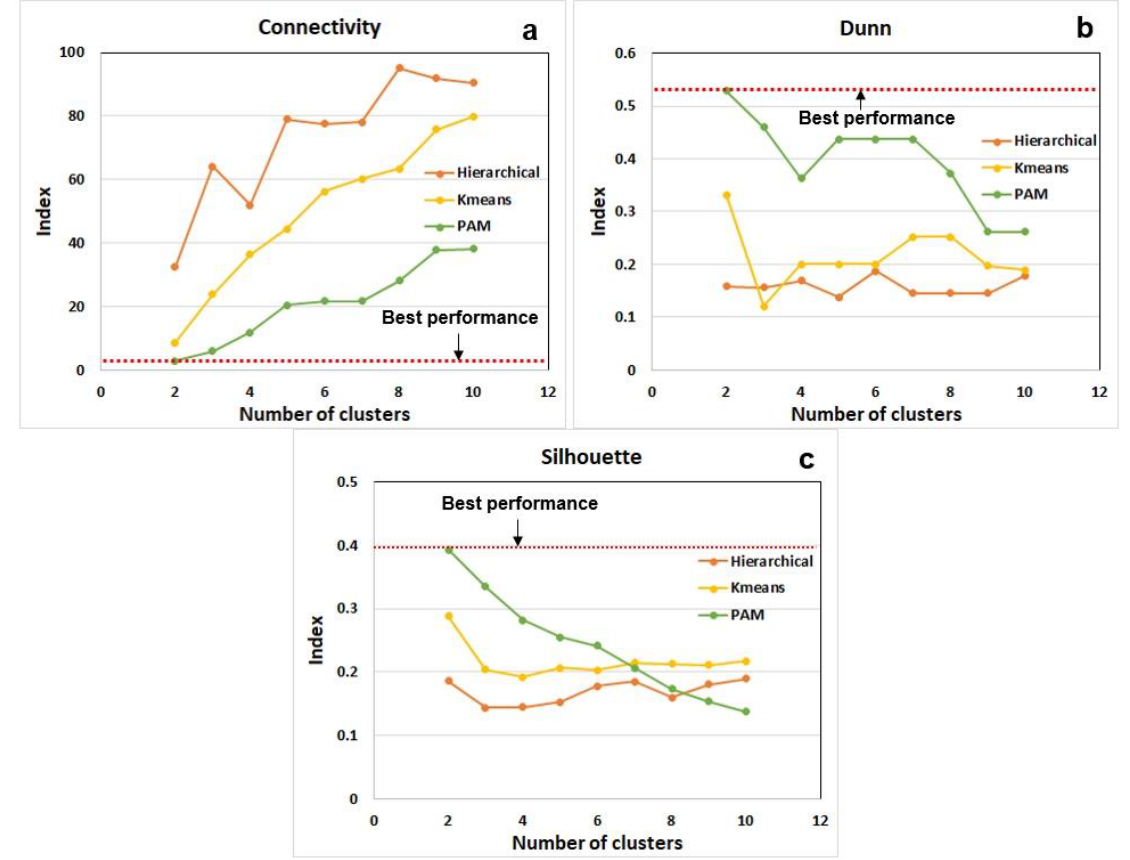
Figure 10. Comparative performance of clustering validity analysis. ( a ) Connectivity ( b ) Dunn ( c ) Silhouette index.